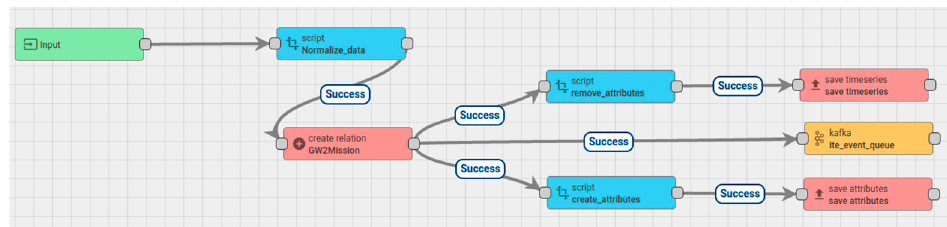
Figure 3. The ThingsBoard rule chain to receive alerts from the mobile